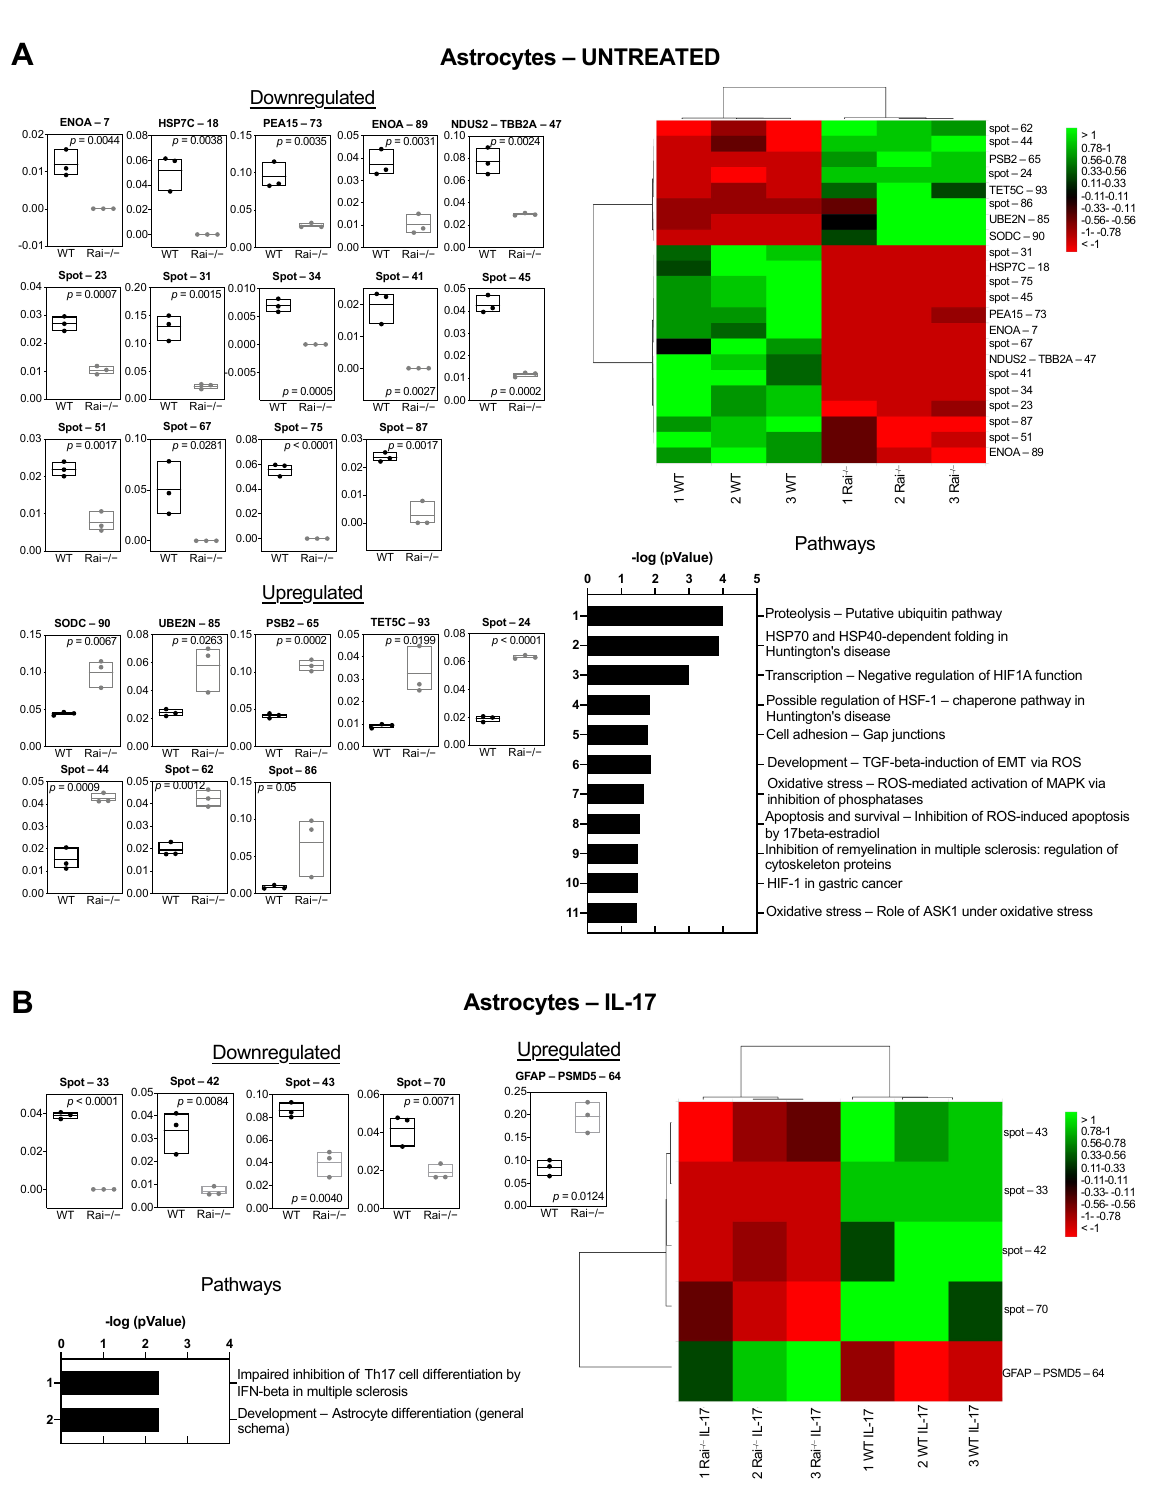
Figure 2. Differential proteomic analysis of control and Rai −/− astrocytes . Supervised hierarchical clustering heat map ( left ) and floating bars (min to max) ( right ) of differentially abundant proteins found in untreated ( A ) and IL-17-treated ( B ) astrocytes purified from control (WT) and Rai −/− mice ( n = 3 WT, 3 Rai −/− ). Heat maps: columns correspond to individual preparations of astrocytes and row to spot identity (protein name, or spot number for not identified spots) is indicated on the right. Color scale (from high value in green to low value in red) illustrates % volume values of the statistically significant differentially abundant spots. The most relevant pathway maps reported by MetaCore, based on all differentially expressed proteins and prioritized according to their statistical significance ( p ≤ 0.001), are shown for each condition.